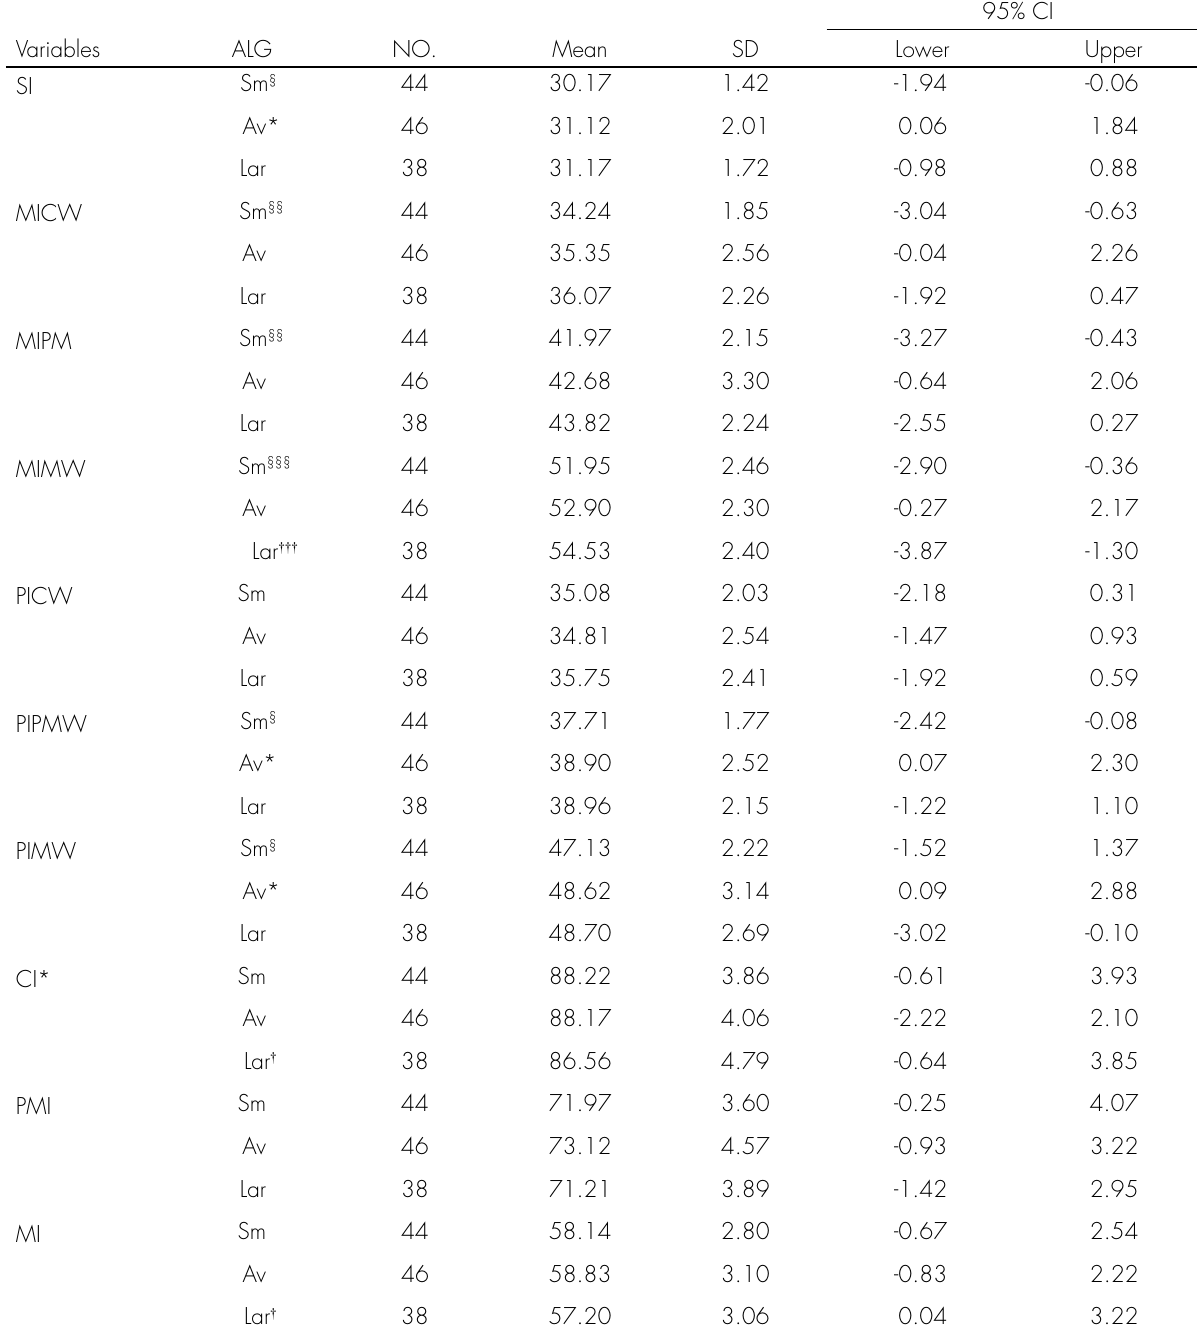
Table III. Comparison of the sum of the incisors, arch width and expansion indices in relation to various arch length groups (ALG) of the maxillary